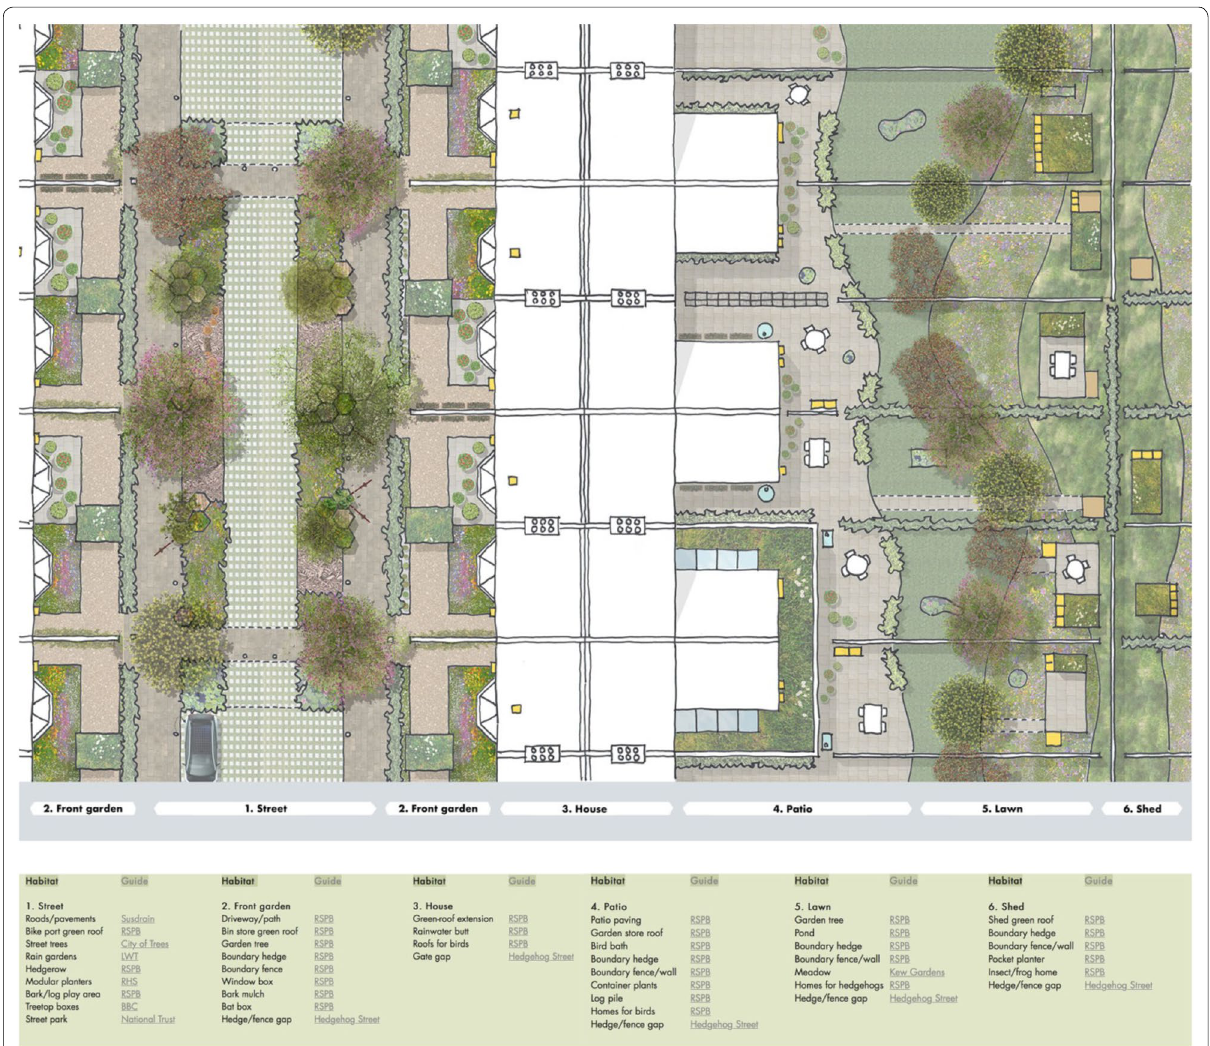
Fig. 2 Street plan showing proposed typical street with adaptations for biodiversity, focusing on habitat (Siân & Jon Moxon & Viktoria